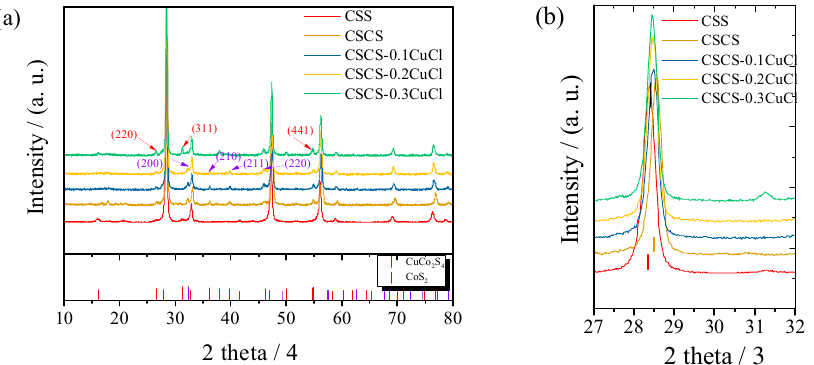
Figure 1. ( a ) Powder X-ray diffraction (XRD) patterns for CSCS- x CuCl ( x = 0, 0.1, 0.2, 0.3) samples and the pristine phase CSS. ( b ) enlarged XRD profile in the range from 27° to 32°.